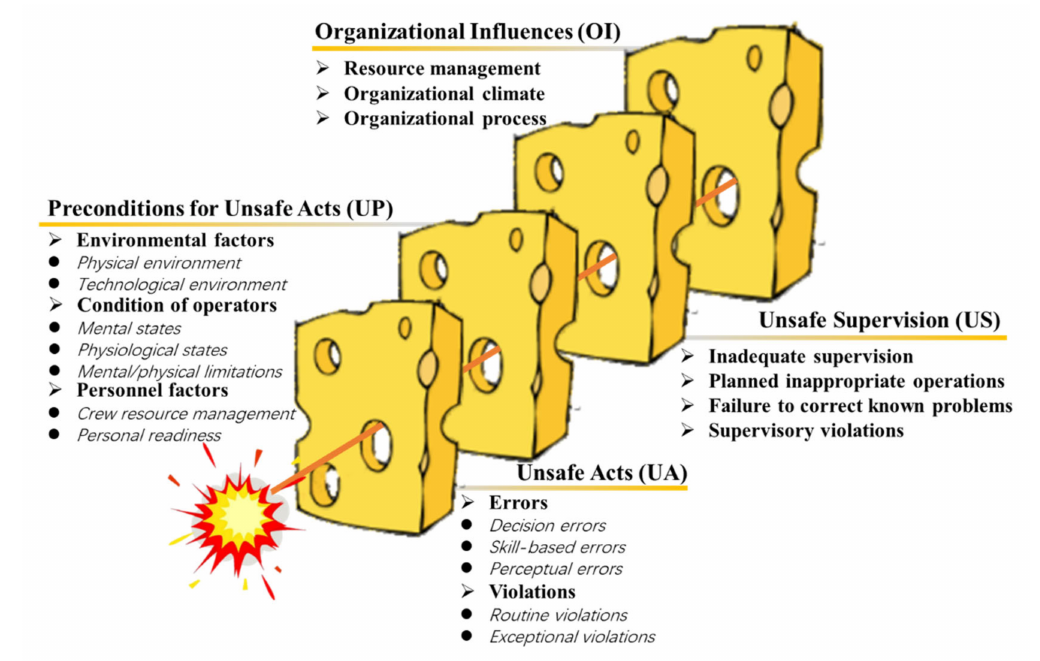
Figure 3. The original framework of